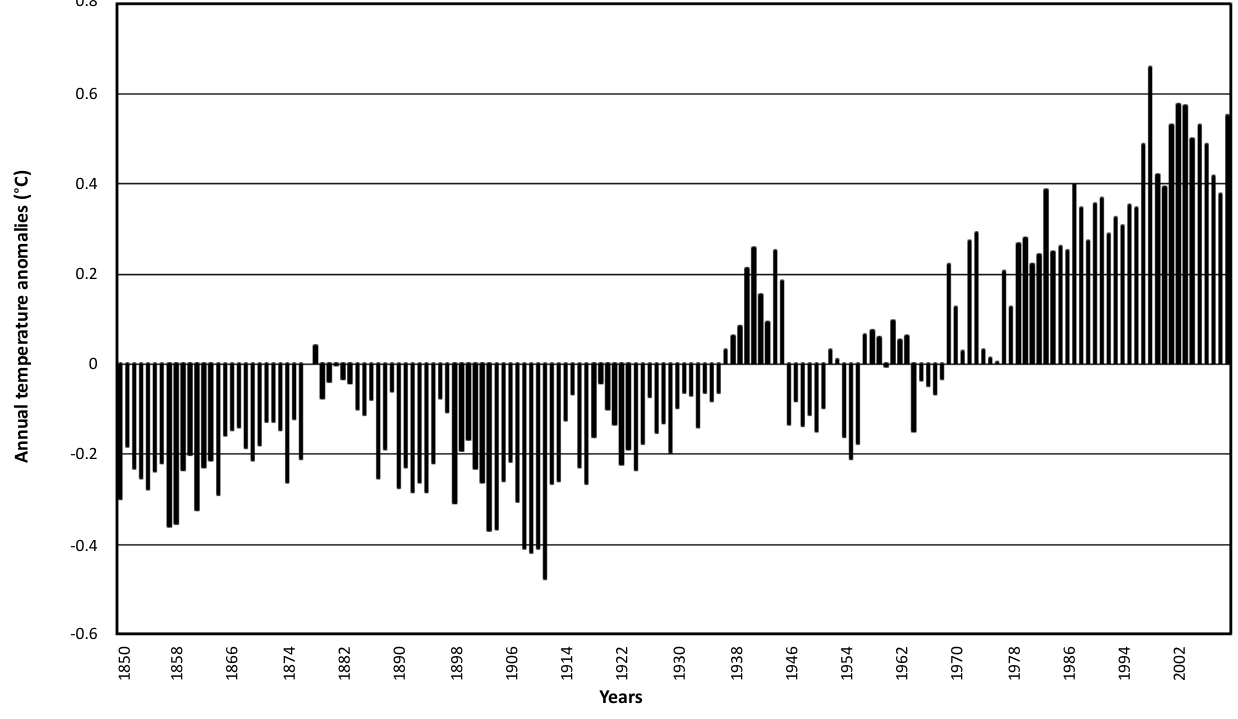
FIGURE 1: Southern hemisphere surface air temperature anomalies between 1850 and